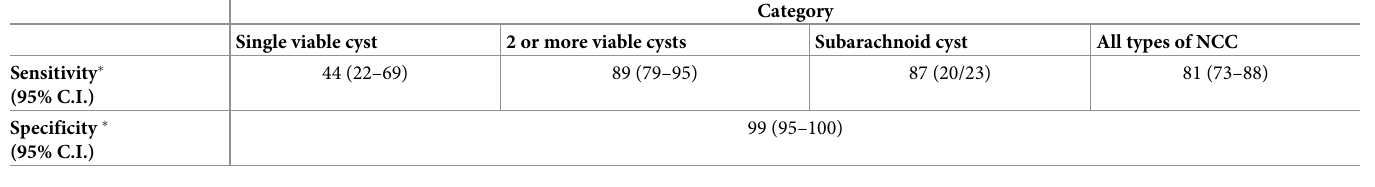
Table 1. Performance of rT24H POC test by category of NCC diagnosed using computed tomography (CT) or magnetic resonance imaging (MRI). Category Single viable cyst 2 or more viable cysts Subarachnoid cyst All types of